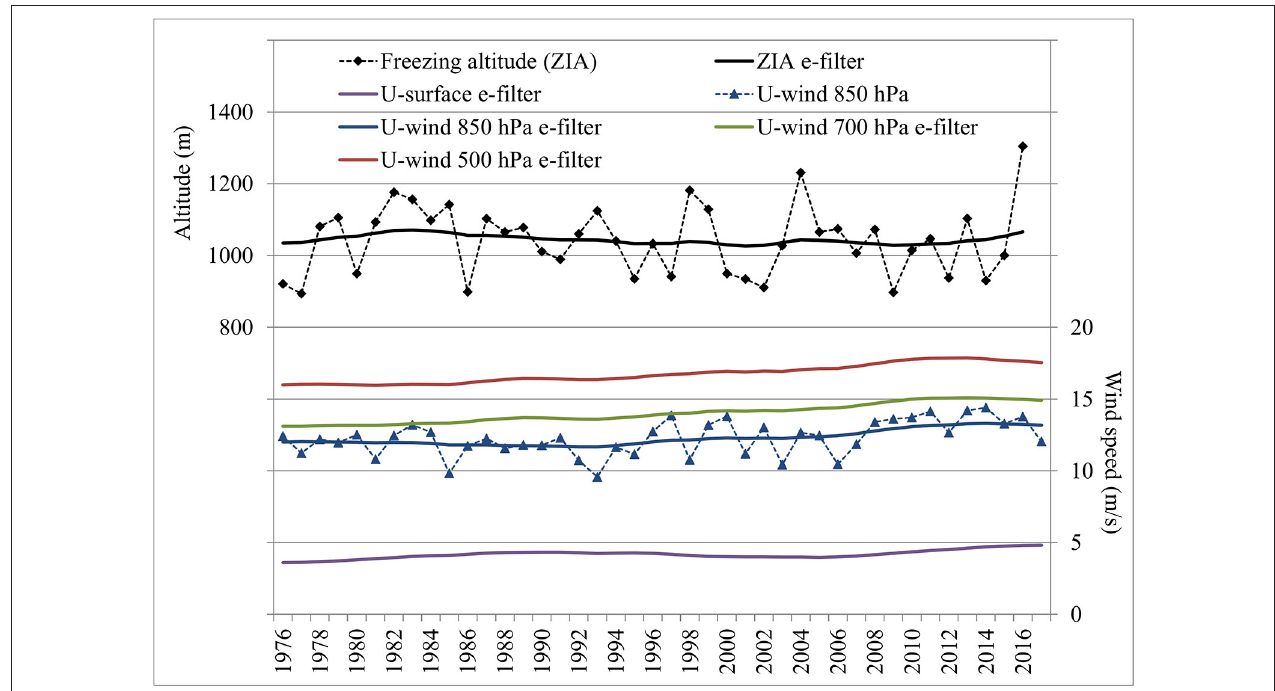
FIGURE 7 | Annual and long-term (using an exponential filter) Zero Isotherm Altitude (ZIA) (black) and zonal wind component at surface (purple), 850 hPa (blue), 700 hPa (green) and 500 hPa (red) from Punta Arenas Airport radiosonde